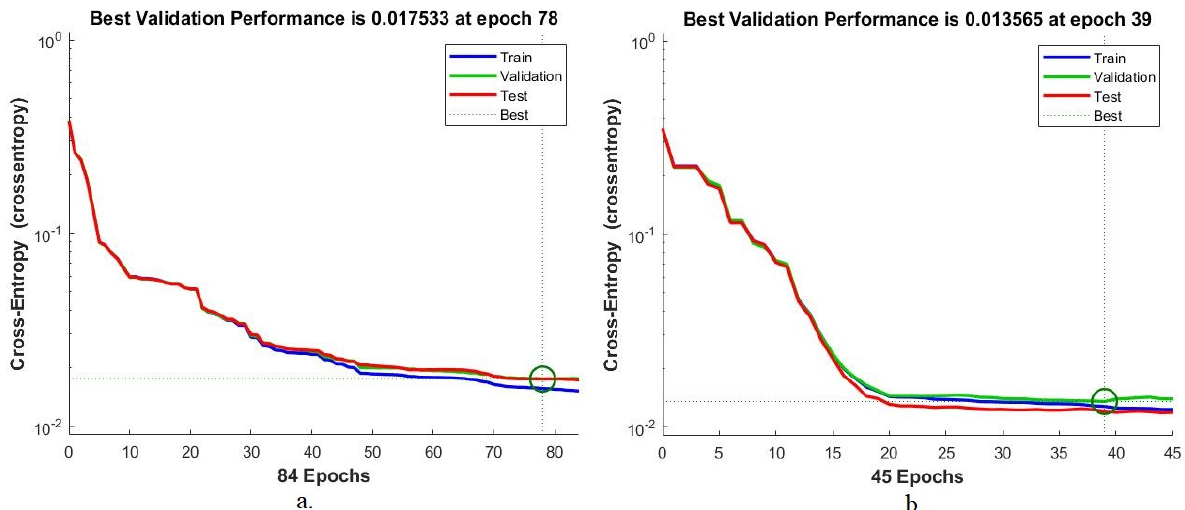
Figure 10. Cross ‐ entropy display for diagnosing abnormal cell images of the cervix by ANN based on the features of ( a ). VGG ‐ 16, FCH, GLCM and LBP and ( b ). GoogLeNet, FCH, GLCM and LBP. on the features of ( a ). VGG-16, FCH, GLCM and LBP and ( b ). GoogLeNet, FCH, GLCM and